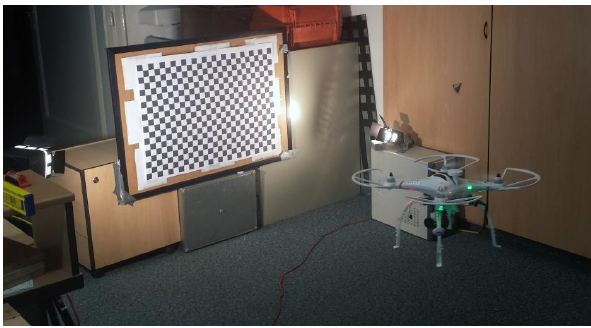
Figure 6. Indoor flight